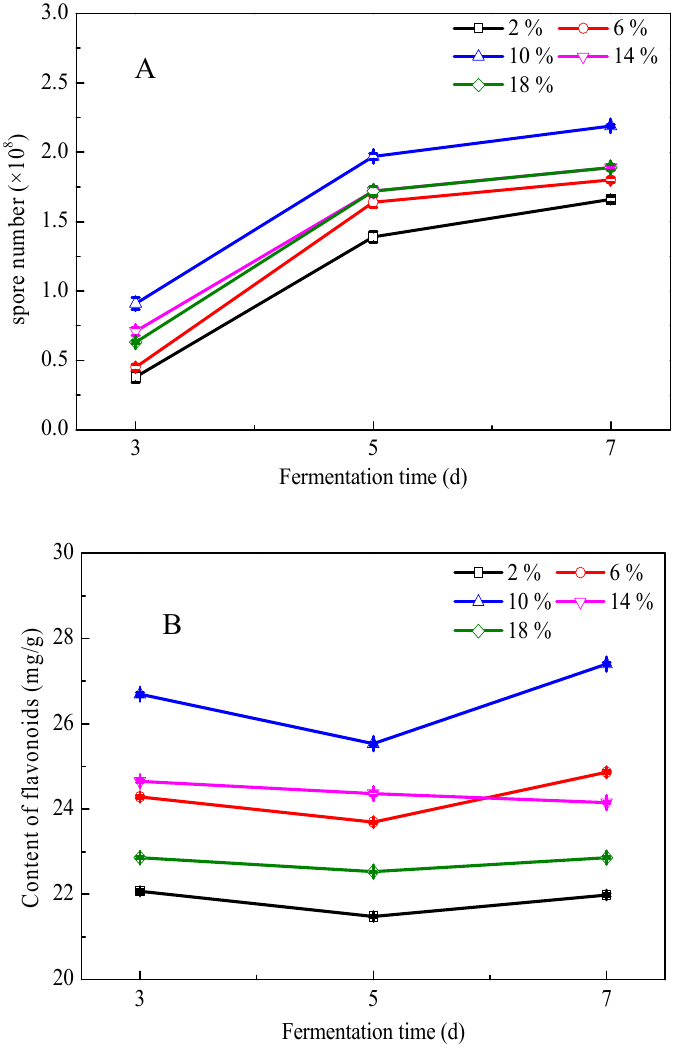
Figure 2. E ff ects of varying amounts of whole G. biloba seeds (%, w / w ) on ( A ) spore number and ( B ) Figure 2. Effects of varying amounts of whole G. biloba seeds (%, w/w ) on ( A ) spore number and ( B ) flavonoid flavonoid content.